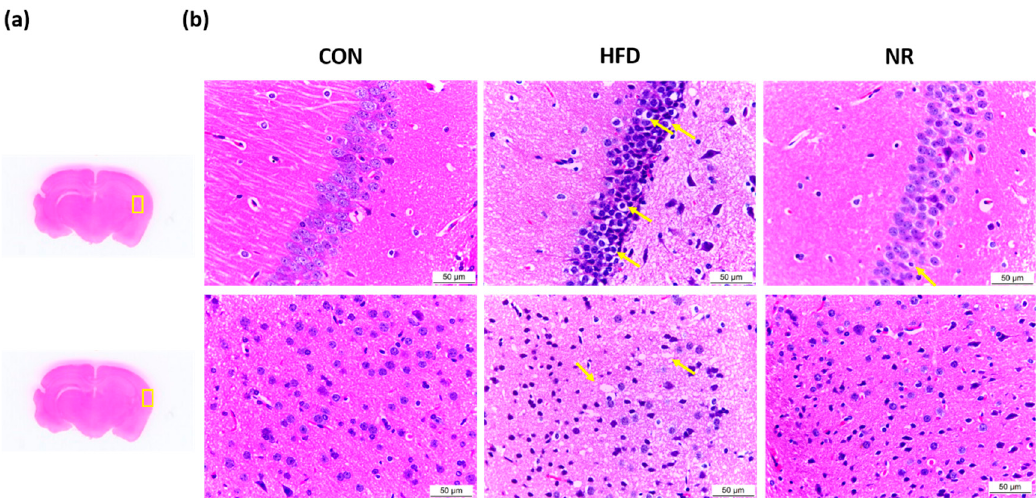
Figure 3. Representative photographs of hematoxylin and eosin (H and E)-stained brain sections. ( a ) The areas examined in the brain were marked with yellow boxes. ( b ) H and E-stained brain sections. Original magnification 400 × . Yellow arrows indicate karyopyknosis of cells. CON, control; HFD, high-fat diet; NR, nicotinamide